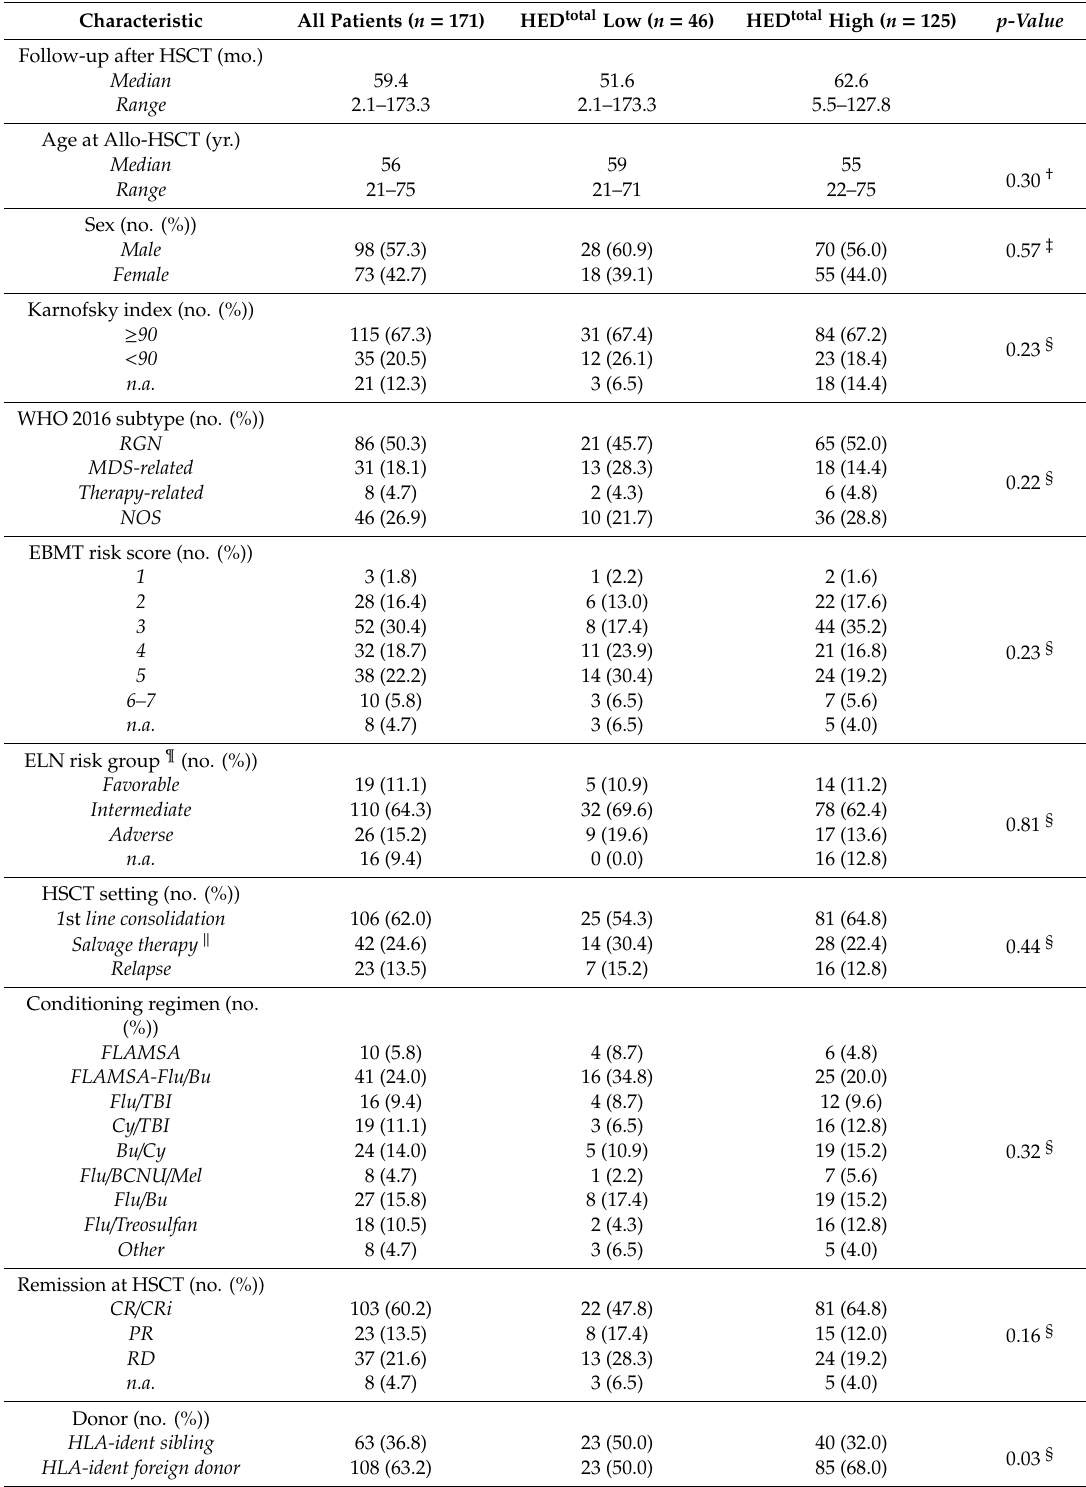
Table 1. Patient